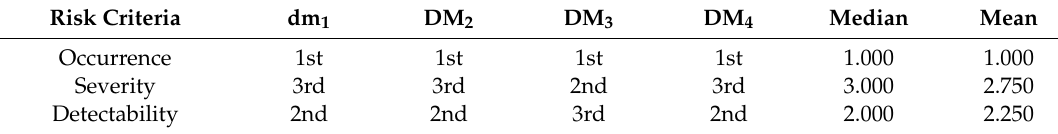
Table 9. Ranking of risk factors.